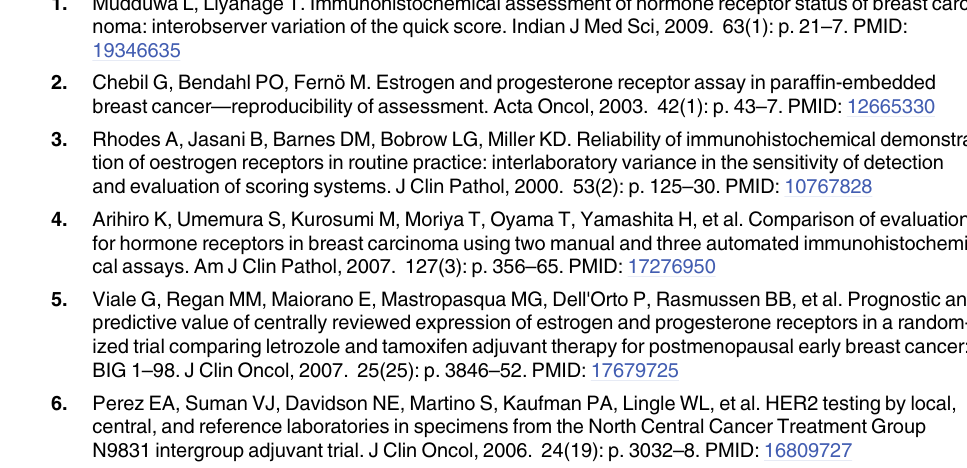
S1 Table. Concordance between local and central laboratories for HER2 assay. (TIFF) S2 Table. MapQuant test values of Estrogen-Receptor (ER), Progesterone-Receptor (PR) and HER2 status compared to immunohistochemistry (IHC) with a 1% cut-off positivity.